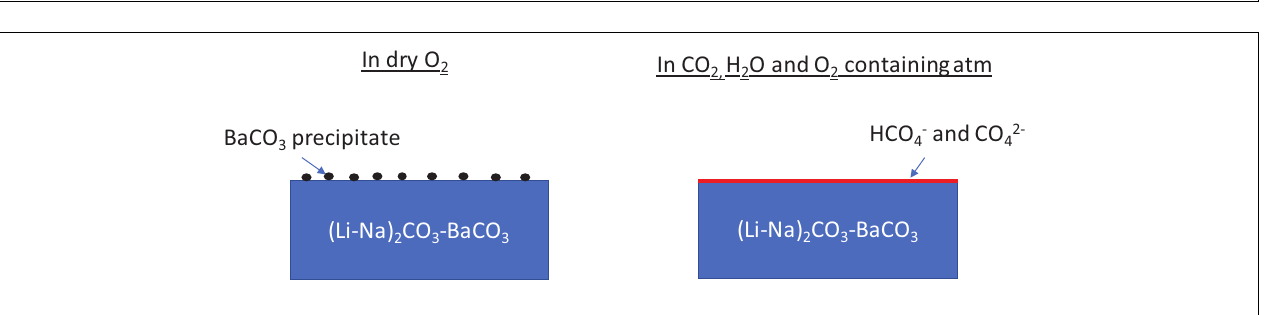
FIGURE 5 | Raman spectra of Ba-added MC collected under different gas conditions at 625 ◦ C.